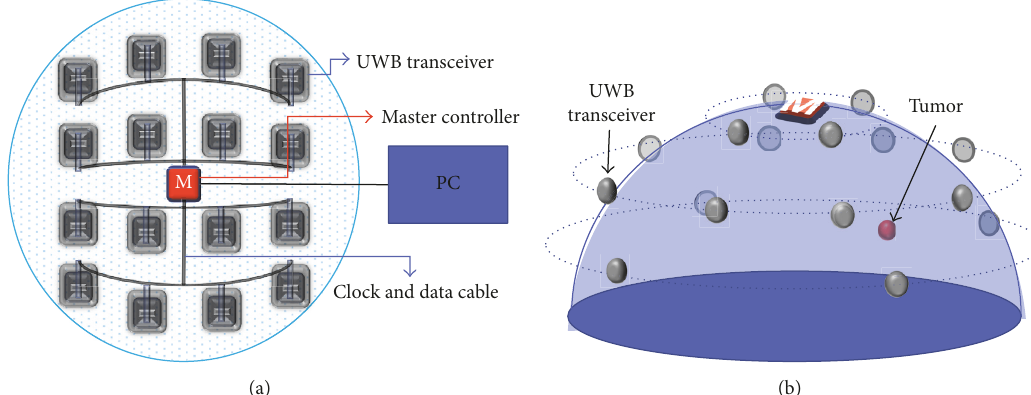
Figure 31: Breast cancer imaging system with 16 UWB transceivers. (a) Configuration of 16 UWB transceivers and master controller and (b) location of 16 UWB transceivers with a 3 mm radius tumor inside [34].